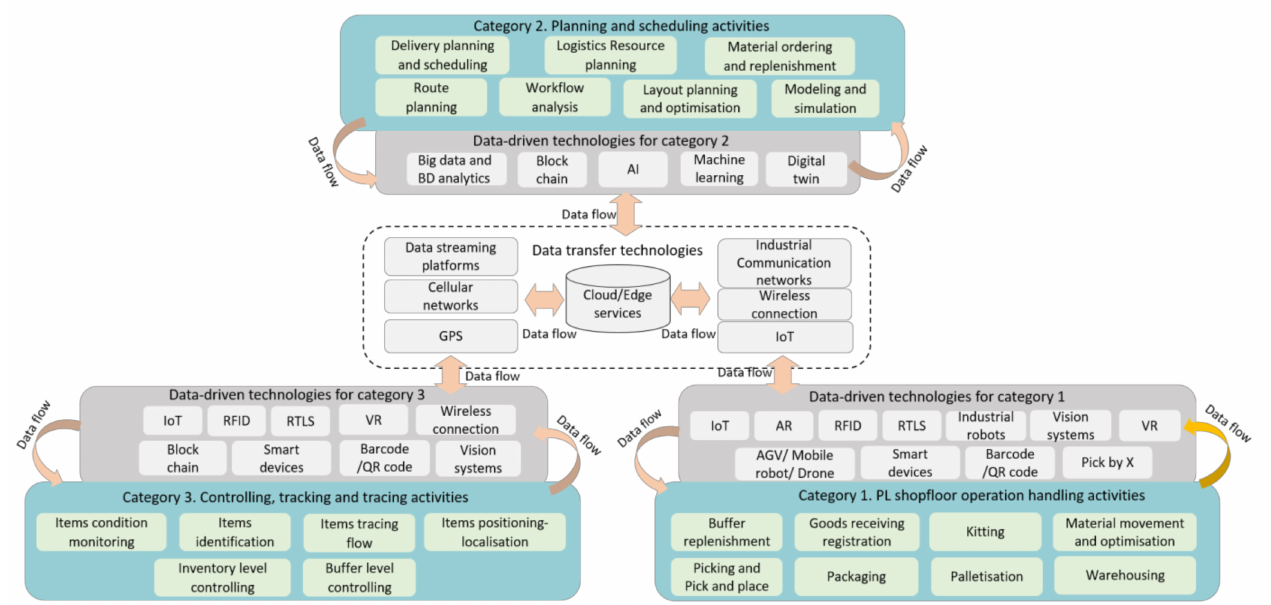
Figure 6. The correlation between three categories of PL activities and their respective data-driven